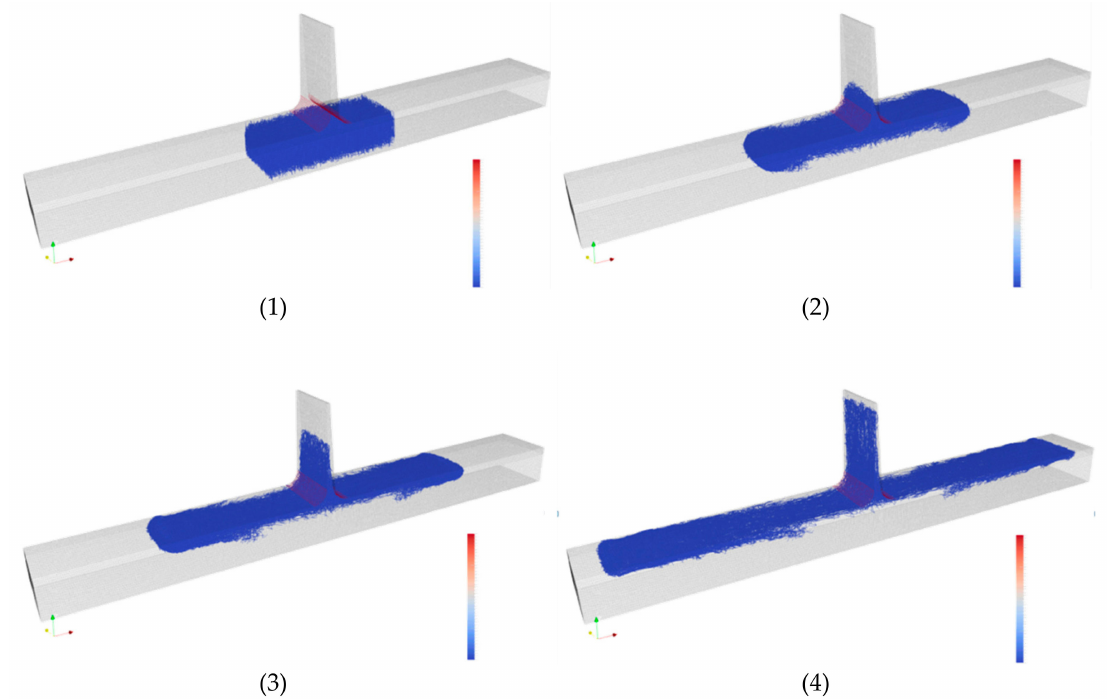
Figure 3. Fiber movement during compression molding simulations with the ribbed plate at consecutive time steps 1–4.